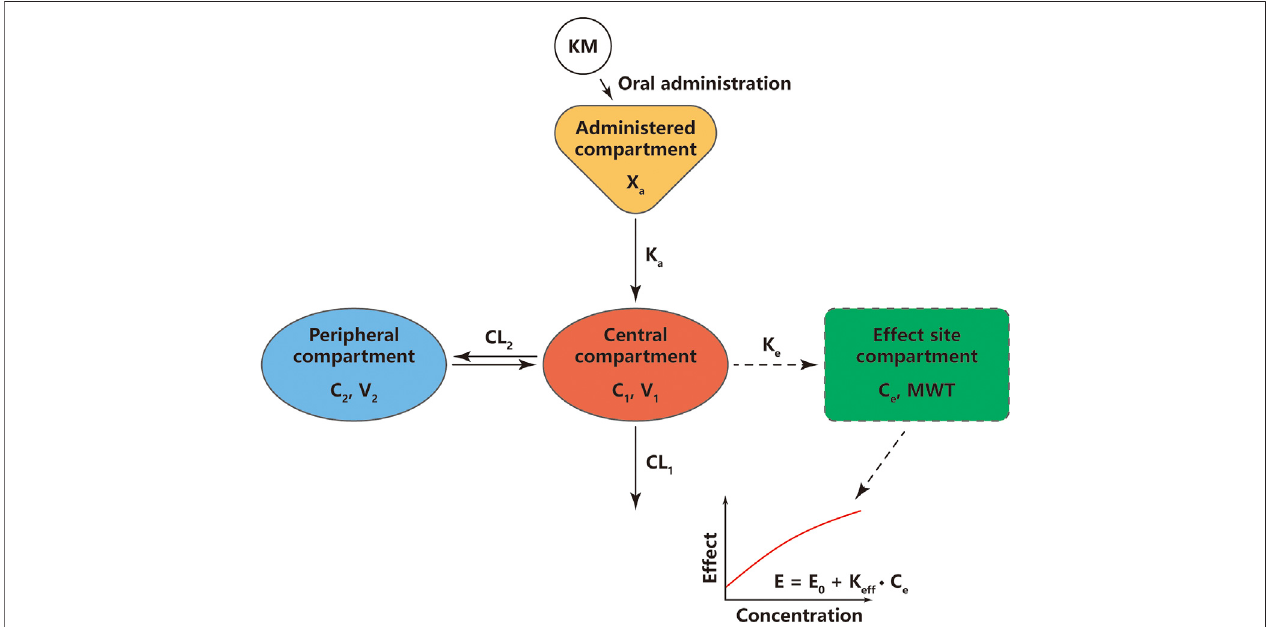
FIGURE 5 | Schematic diagram of pharmacokinetic and pharmacodynamic modeling of koumine (KM) for its effects on mechanical withdrawal threshold (MWT). X a , the amount of KM at the administered compartment; K a , absorption rate constant; C 1 , KM concentration in the central compartment; C 2 , KM concentration in the peripheral compartment; V 1 , central volume of KM distribution; V 2 , peripheral volume of KM distribution; CL 1 , systemic clearance rate; CL 2 , inter-compartmental clearance rate; E , the fi nal effects of KM; E 0 , the baseline value of the MWT; K eff , slope of linear function in KM effect; K e , fi rst-order rate constant governing the equilibrium distribution of KM between plasma and the effect